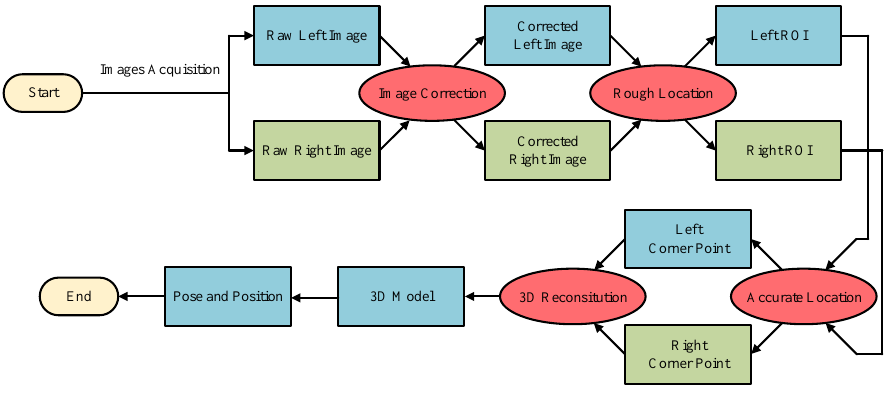
Figure 6. Flowchart of the RAL